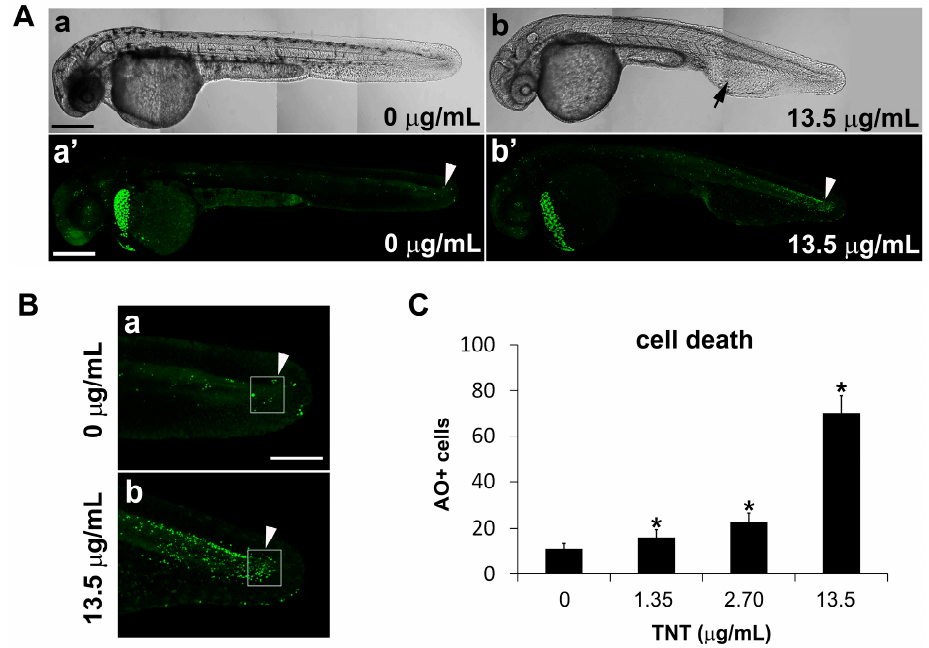
Figure 5. TNT in pink water increases the number of apoptotic cells in zebrafish embryos at 35 hpf. ( A ) Bright field images ( a , b ) and fluorescence images of acridine orange staining ( a ′ , b ′ ) by confocal microscopy show apoptosis in live whole embryos following treatment from 5–35 hpf with pink water containing TNT at 0 ( a , a ′ ) and 13.5 µg/mL ( b , b ′ ). Four tiled confocal images were combined to show the whole embryo in each case. Scale bar 500 µm. TNT treatment causes defective development of blood island and abnormal blood circulation ( b , arrow) and more apoptosis in actively developing tissues of the tail ( b ′ , arrowhead) compared with control ( a ′ , arrowhead); ( B ) Magnified view of the tail regions of the embryos in ( A ) showing apoptotic cells (green dots); ( a ) is from A ( a ′ ) and ( b ) is from A ( b ′ ) respectfully. Scale bar 150 µm; ( C ) Number of acridine orange-positive apoptotic cells (AO + cells) in the boxed area in actively developing tail tissue ( B , arrowhead) was counted at different concentrations of TNT using an Axioimager II fluorescence microscope. Cell death in TNT-treated embryos increased in a dose-dependent manner. n = 10 for each treatment, * p < 0.001.